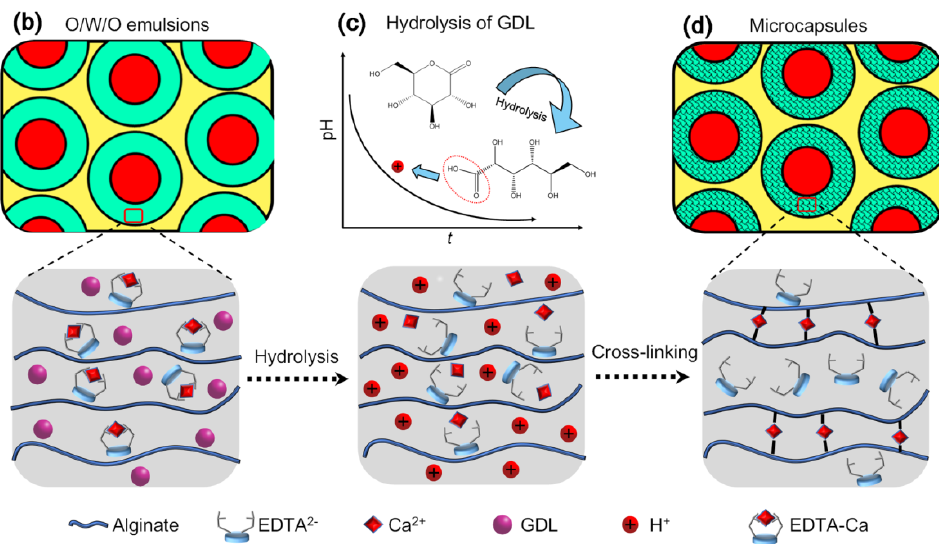
Figure 1. Schematic illustration for the preparation of alginate microcapsules under mild conditions. Monodispersed oil-in-water-in-oil (O/W/O) emulsions are generated in a two-staged microfluidic device ( a ). The middle aqueous phase of O/W/O emulsions contains sodium alginate, calcium–ethylenediaminetetraacetic acid (EDTA-Ca) as calcium source, and D-(+)-Gluconic acid δ -lactone (GDL) as acidifier ( b ). The hydrolysis of GDL in aqueous solution will decrease the pH value and trigger the calcium ions released from the EDTA-Ca complex ( c ). After the alginate molecules are cross-linked with the liberated calcium ions, the O/W/O emulsions will convert to alginate microcapsules ( d ). Citral could be encapsulated into alginate microcapsules by dissolving it in the inner fluid beforehand.